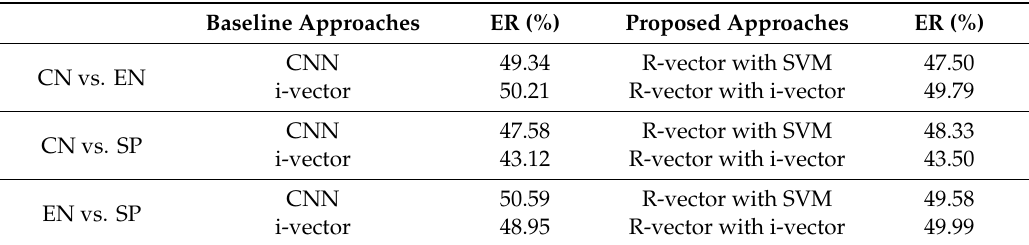
Table 8. Performance (Error Rate (ER)) of two-class LID experiments on the 2011 National Institute of Standards and Technology (NIST) Language Recognition Evaluation (LRE) test set.